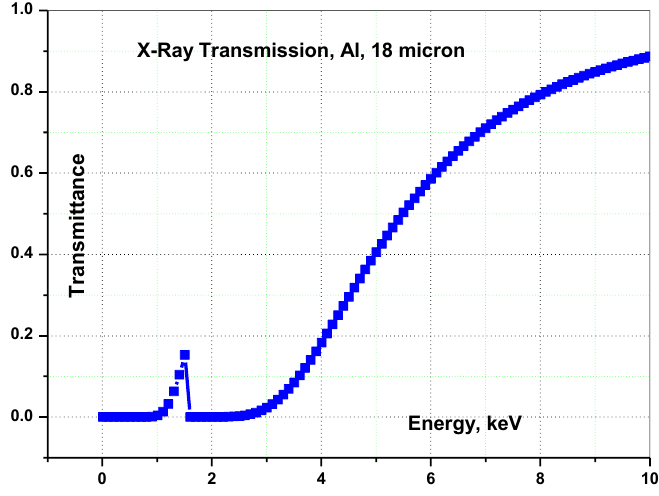
Figure 6. Graph showing the X-ray transmission of 18  m thick sheet of Al, Z=13.